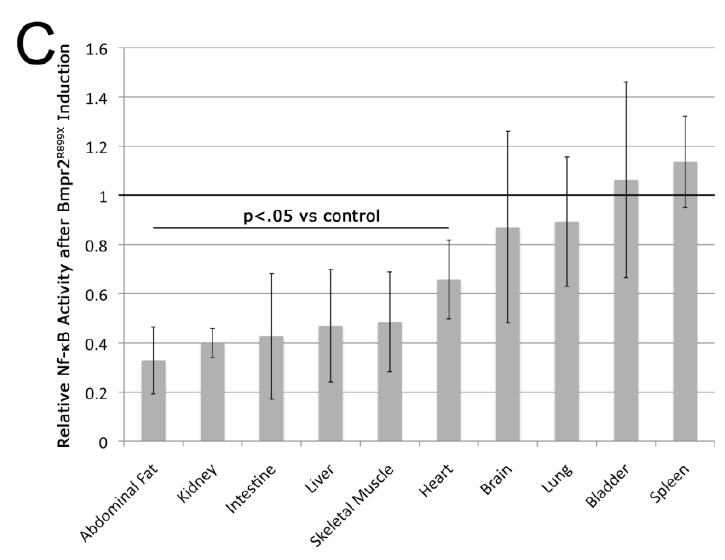
Figure 4. NF- κ B activation is not required for murine Bmpr2-related pulmonary